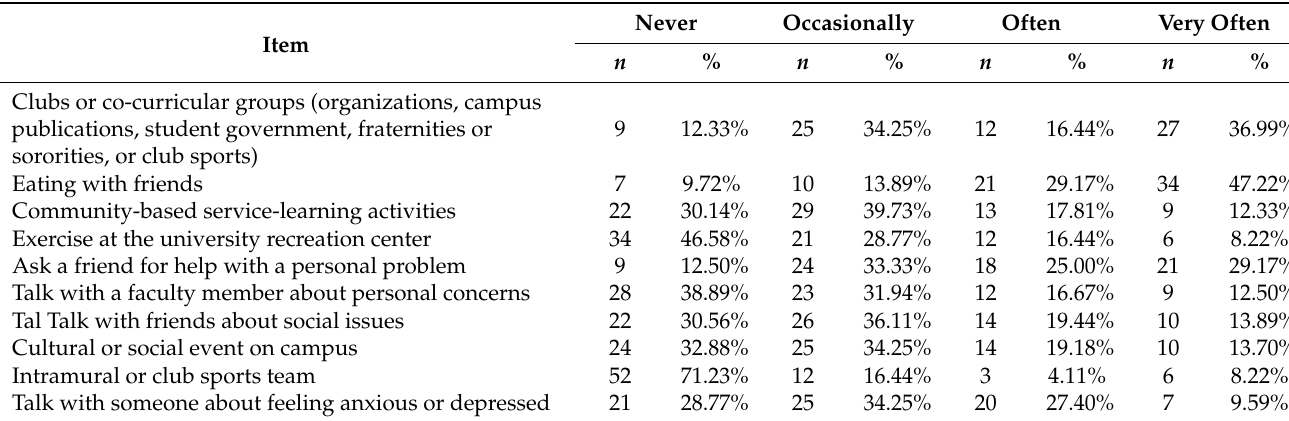
Table 6. Informal Social Supports.